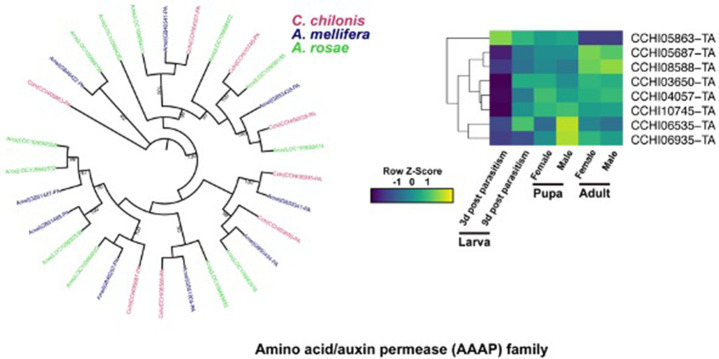
Phylogenetic relationships of the AAAP family and gene expression in C. chilonis at different development stages.